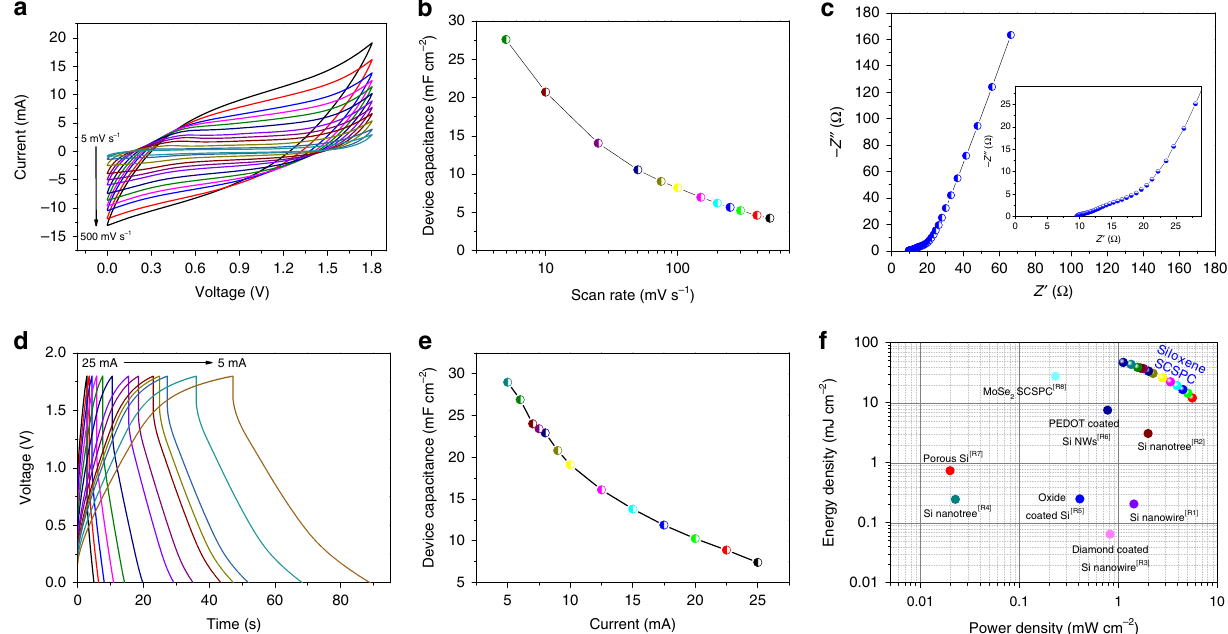
Fig. 5 Electrochemical energy storage properties of siloxene SCSPC. a Cyclic voltammetric pro fi les of the siloxene SCSPC recorded with different applied scan rates from 5 to 500 mV s − 1 . b Effect of applied scan rates on the speci fi c device capacitance of siloxene SCSPC. c Electrochemical impedance spectroscopic analysis of the siloxene SCSPC in the form of a Nyquist plot and the inset in c presents the enlarged portion of the high-frequency region. d Galvanostatic charge – discharge pro fi les of the siloxene SCSPC recorded using different applied current ranges. e Effect of discharge current ranges of the speci fi c device capacitance of siloxene SCSPC, and f energy – power performance metrics of the siloxene SCSPC provided in the form of Ragone plot. The references given in the inset of f are provided in Supplementary Table 1. of the ionogel compared to that of the liquid electrolyte 35 . The observation of a quasi-semicircle such as an arc in the high- frequency region is due to the charge-transfer resistance ( R ct of 4 Ω ) of the siloxene SCSPC 33 . The low-frequency region shows the Figure 5c represents the EIS data of the siloxene SCSPC device in evidence of a straight line (Warburg line) that runs almost par- the form of a Nyquist plot (plot of real versus imaginary com- allel to the y- axis, which indicates the charging region of the ponent of the impedance). The Nyquist plot of the siloxene siloxene SCSPC as a result of electrolyte ions diffusion into the SCSPC device shows the presence of three well-de fi ned regions, electrode surface 36 . The Bode phase angle plot of siloxene SCSPC (see Supplementary Fig. 6) shows that the phase angle at the low the low-, medium-, and high-frequency regions, which directly frequency (0.01 Hz) is approximately − 69°, thus revealing the relate to the frequency-dependent synchronous-, asynchronous-, pseudocapacitive behavior of the electrode 37 . and noncharging behavior of the siloxene SCSPC 34 . From the inset of Fig. 5c, the equivalent series resistance (ESR) of the Figure 5d represents the CD pro fi les of the siloxene SCSPC device siloxene SCSPC is found to be 9.7 Ω . This value is relatively recorded using different applied current ranges over an OVW of higher than that of the siloxene supercapacitor using liquid 1.8 V. The presence of slopped symmetric triangular-shaped TEABF 4 electrolyte 23 , which is due to the low ionic conductivity CD pro fi les of siloxene SCSPC revealed the pseudocapacitive